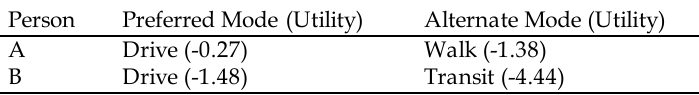
Table 6. Utility Summary of Vehicle Allocation